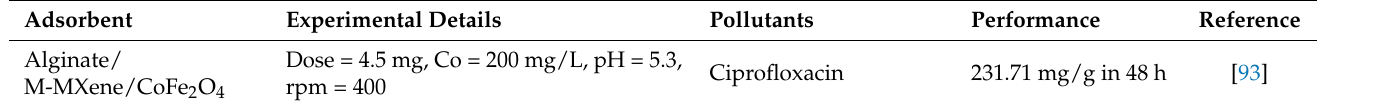
Table 3. Adsorption of different organic pollutants using MXene-based adsorbents. Adsorbent Experimental